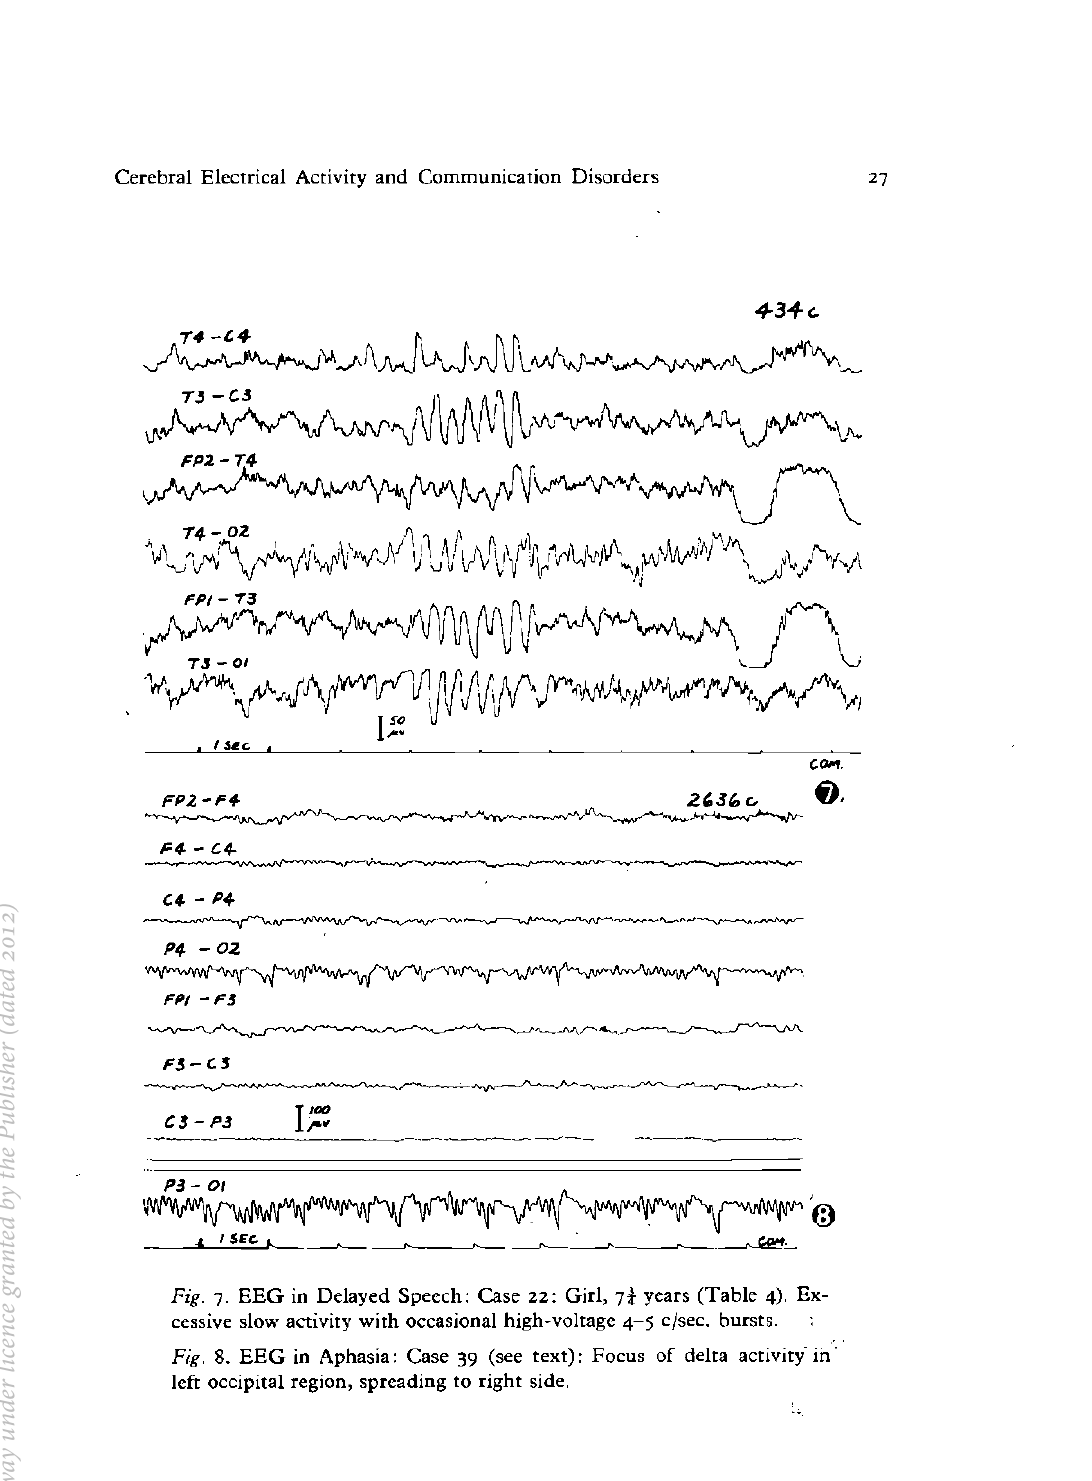
Fig. 7. EEG in Delayed Speech: Case 22: Girl, 7 J years (Table 4). Ex- cessive slow activity with occasional high-voltage 4-5 c/sec. bursts. Fig. 8. EEG in Aphasia: Case 39 (see text): Focus of delta activity in' left occipital region, spreading to right